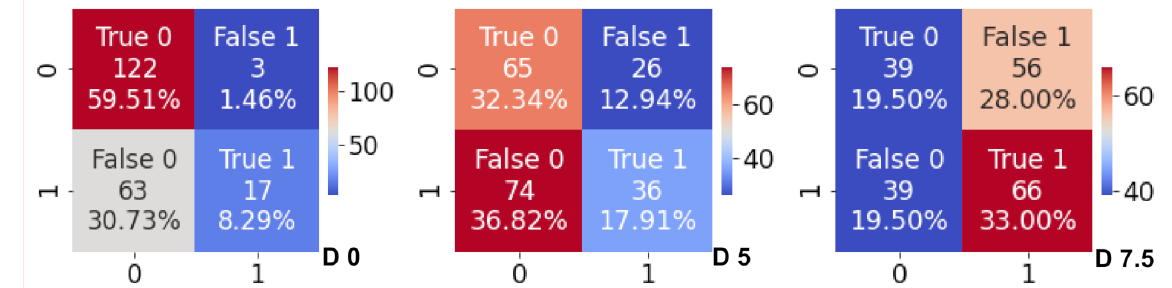
Figure 11. Confusion matrices showing the percentage of data in each position, where class 0 refers to NWW3 and class 1 refers to GWES. The positions are true 0 (correctly classifying class 0), false 1 (falsely classifying as class 1), false 0 (falsely classifying as class 0), and true 1 (correctly classifying class 1). The three plots are associated with the forecast lead times: day 0 (left), day 5 (center), and day 7.5 (right), indicated in the